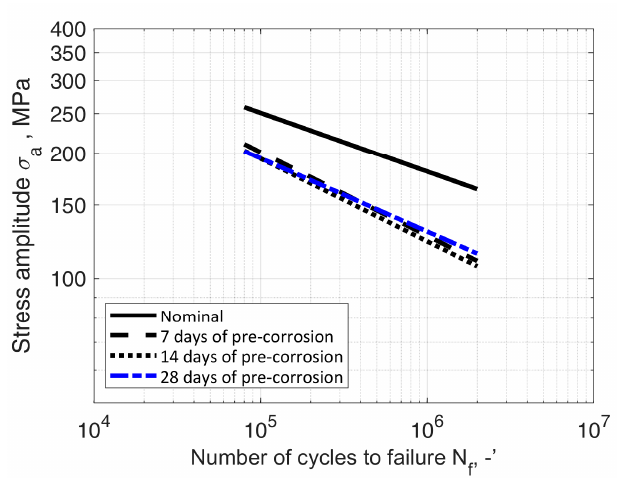
Figure 19. S-N data of AW-2017A-T4 material in nominal condition (room temperature, in air) and samples immersed in demineralised water solution for 7, 14 and 28 days prior to bending fatigue tests.